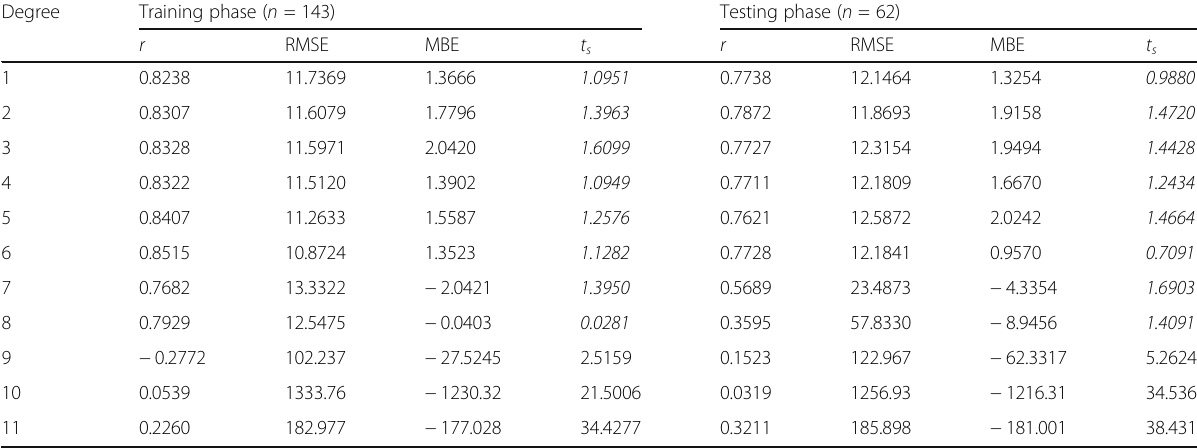
Table 5 Statistical results for each degree of polynomial kernel function of SVR in estimation of cloudless DLR and the statistically significant models are in italics